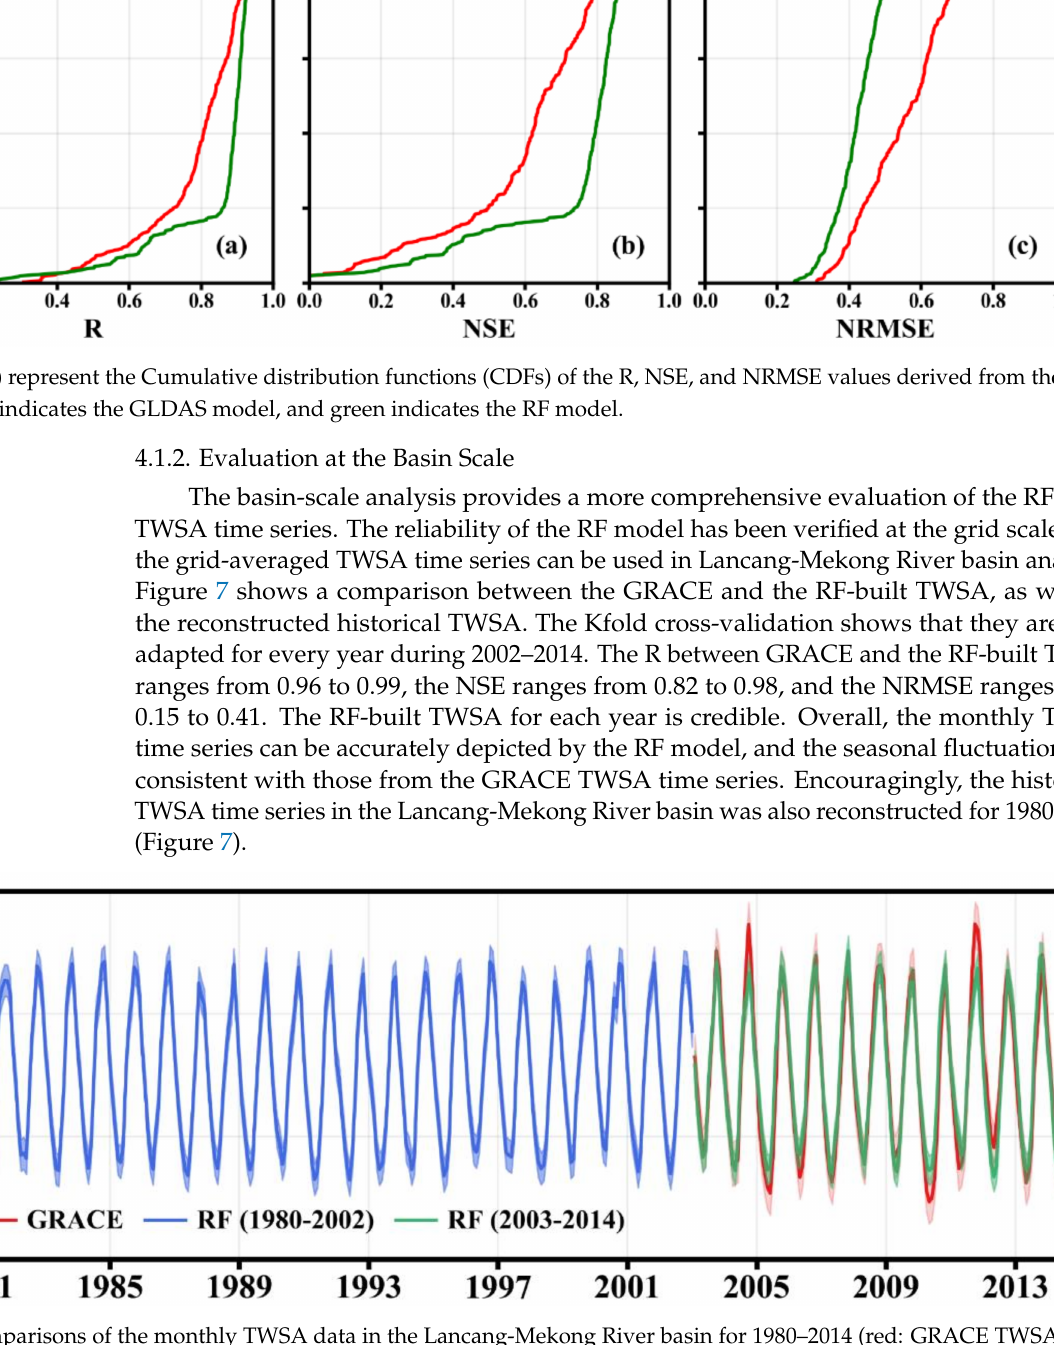
Figure 7. Comparisons of the monthly TWSA data in the Lancang-Mekong River basin for 1980–2014 (red: GRACE TWSA, green/blue: RF-built TWSA), and the shade represents the uncertainty in TWSA